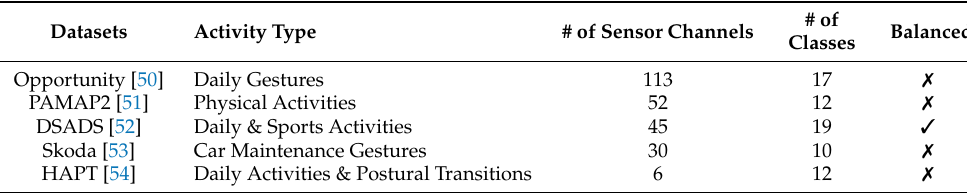
Table 2. Summary of Selected